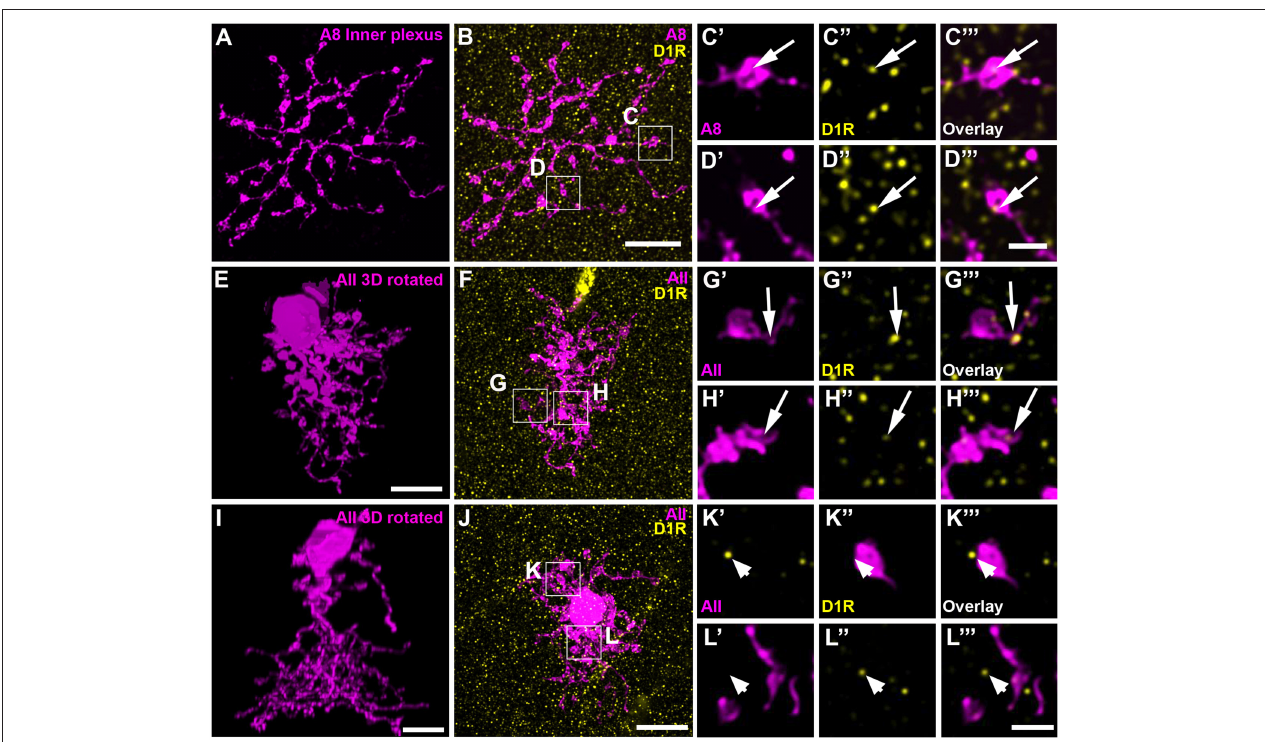
FIGURE 7 | D 1 receptors colocalized with the ON dendrites of A8 cell and most but not all AII cells. (A) Maximum projection of the inner dendrites of a dye-injected A8 cell. (B) Overlay of the A8 ON dendrites and D 1 receptors (D1R), shown as maximum projection. (C,D) Selected ROI from B. (C’–D”’) Magnified images of A8 dendrites (C’,D’) , D 1 receptors (C”,D”) , and their respective overlay (C”’,D”’) within a single section from the selected ROI. Arrows denote colocalization of D 1 receptors with A8 ON dendrites. (E–H”’) Same as (A–D”’) for an injected AII cell. Arrows point to D 1 receptor immunoreactivity colocalizing with AII dendrites. (I–L”’) Same as (E–H”’) , however, this AII cell did not show colocalization with D 1 receptor staining (arrowheads), consistent with a previous report on the rat retina ( Veruki and Wässle, 1996). Scale bar: (A,B,E,F,I,J) , 10 µ m; (C’–D”’) , (G’–H”’) , (K’–L”’) , 2 µ m.